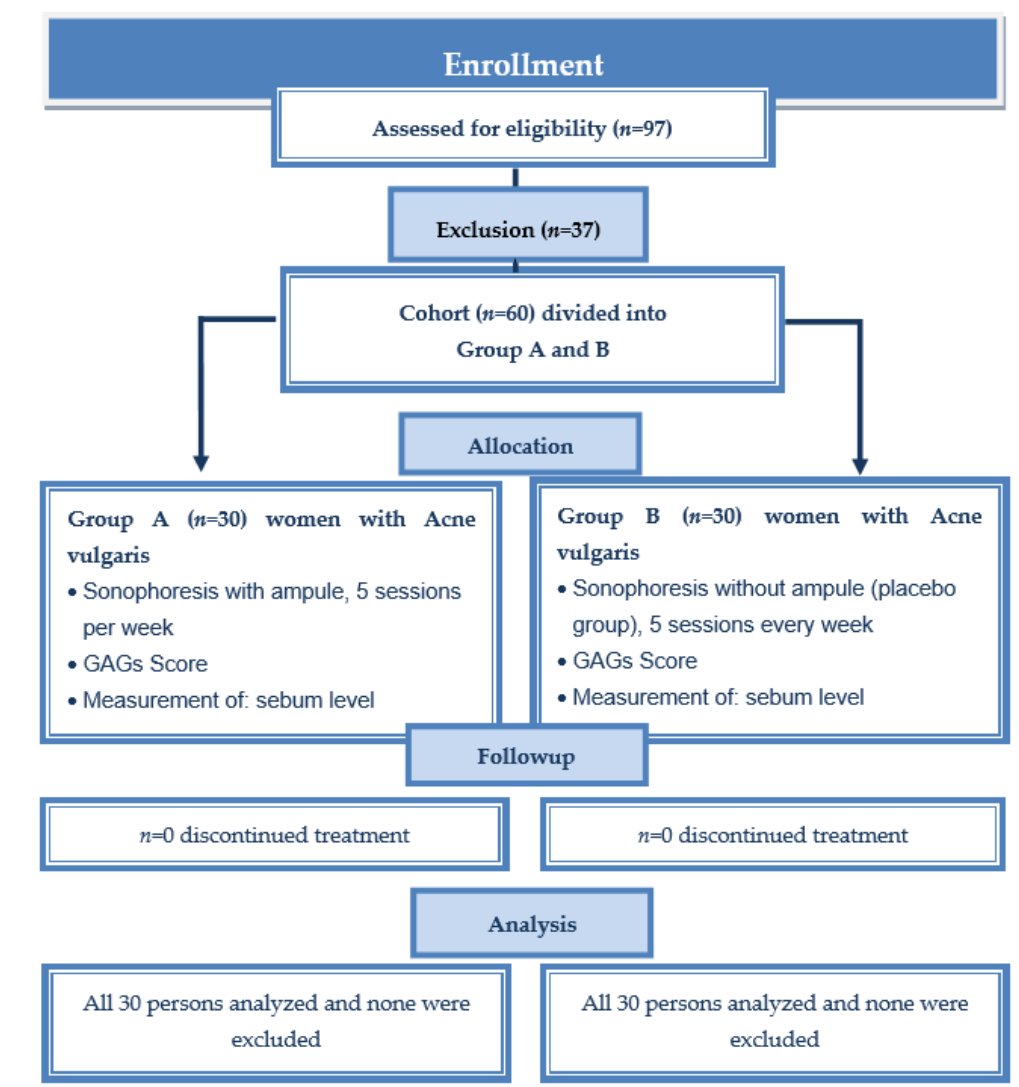
Figure 1. Consort flow chart of clinical study group A and group B